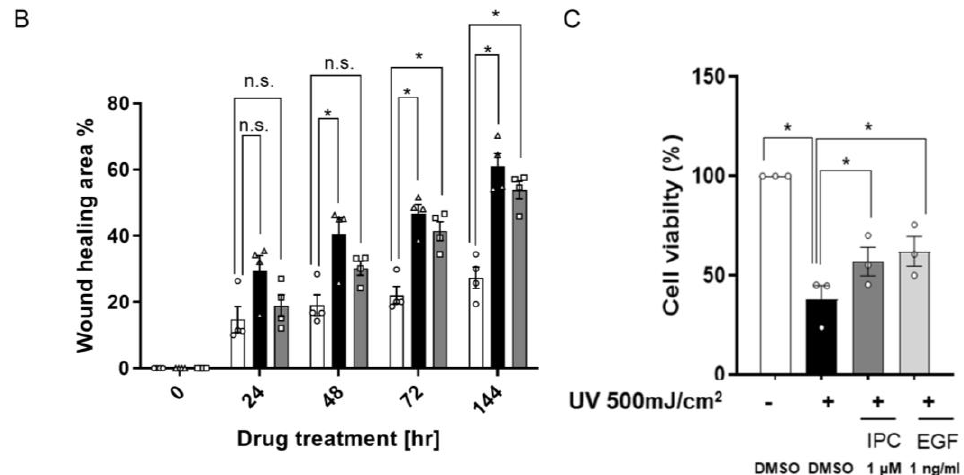
Figure 4. The effect of IPC on cell recovery and wound healing. ( A , B ) Representative image ( A ) and the quantification ( B ) of wound healing effect of IPC. Wounds were generated by scratching the bottom of the plate with a pipette tip. Cells were incubated with IPC for up to 144 h. The area of the wounds, indicated by the yellow dotted line, were measured at each indicated time point to observe the wound healing effect. DMSO was used as a negative control, while EGF was used as a positive control. The color of bar graph indicates following conditions: white—DMSO, black—EGF, and gray—IPC ( n = 4). n.s., not significant, * p < 0.05; unpaired Student’s t test; error bars indicate SEM. ( C ) Measuring the cell recovery effect of IPC after UVB damage. HaCaT cells were exposed to UVB (500 mJ/cm 2 ) before being treated with either DMSO, EGF, or IPC. CCK-8 was used to measure the viability of UBV-damaged HaCaT cells. DMSO was used as a negative control, while EGF was used as a positive control ( n = 3). n.s., not significant, * p < 0.05; unpaired Student’s t test; error bars indicate SEM.